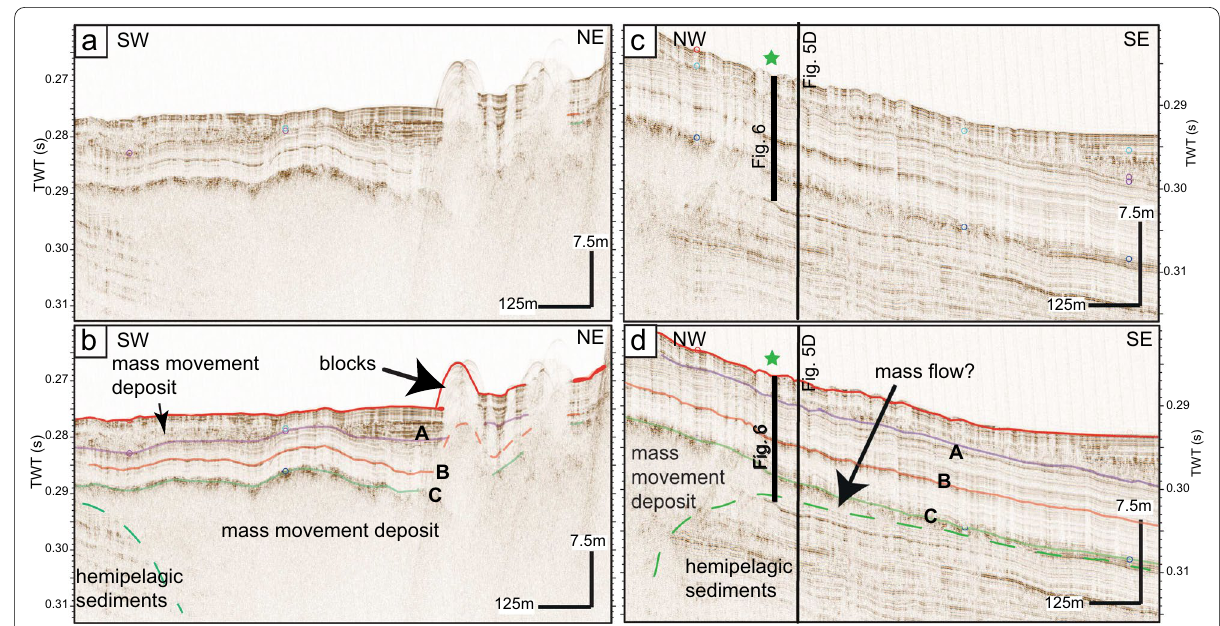
Fig. 4 Uninterpreted ( a and c ) and interpreted ( b and d ) high-resolution 3.5 kHz reflection seismic profiles. Profile a / b is a SW-NE profile crossing the discussed mass-movement deposit. Profile c / d is a NW–SE profile imaging the seismic facies at the coring position (marked with a star on the profile and Fig. 1), the black rectangle indicates the penetration depth of the sediment core. The vertical black line shows the intersection with the profile in Fig. 5d. Profile locations are shown in Fig.